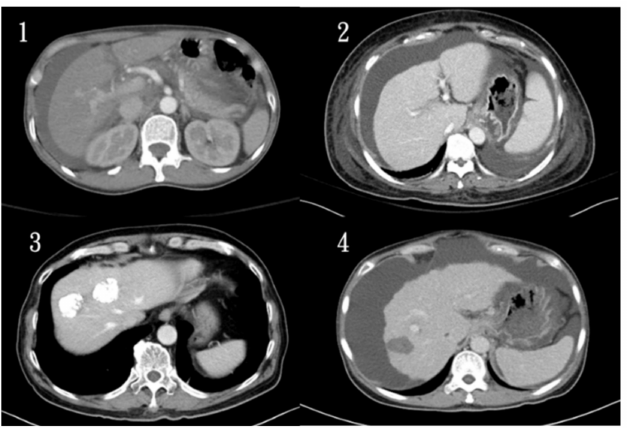
Figure 1. Common problems of medical imaging in current medical centers (1. normal images, 2. contrast-delay phase, 3. post-TAE, and 4. RFA).